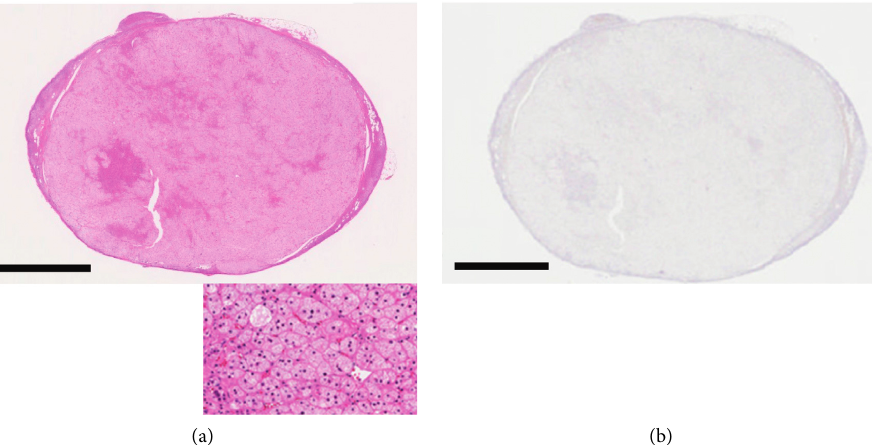
Figure 3: Histopathological findings of the adrenocortical adenoma. (a) Hematoxylin and eosin staining. The adrenocortical tumor was predominantly composed of clear cells. These characteristics are consistent with those of adrenocortical adenoma. Bar, 3 mm. (b) Cy- tochrome P450 11B2 (CYP11B2) immunostaining. The tumor cells were negative for CYP11B2. Bar, 3mm.